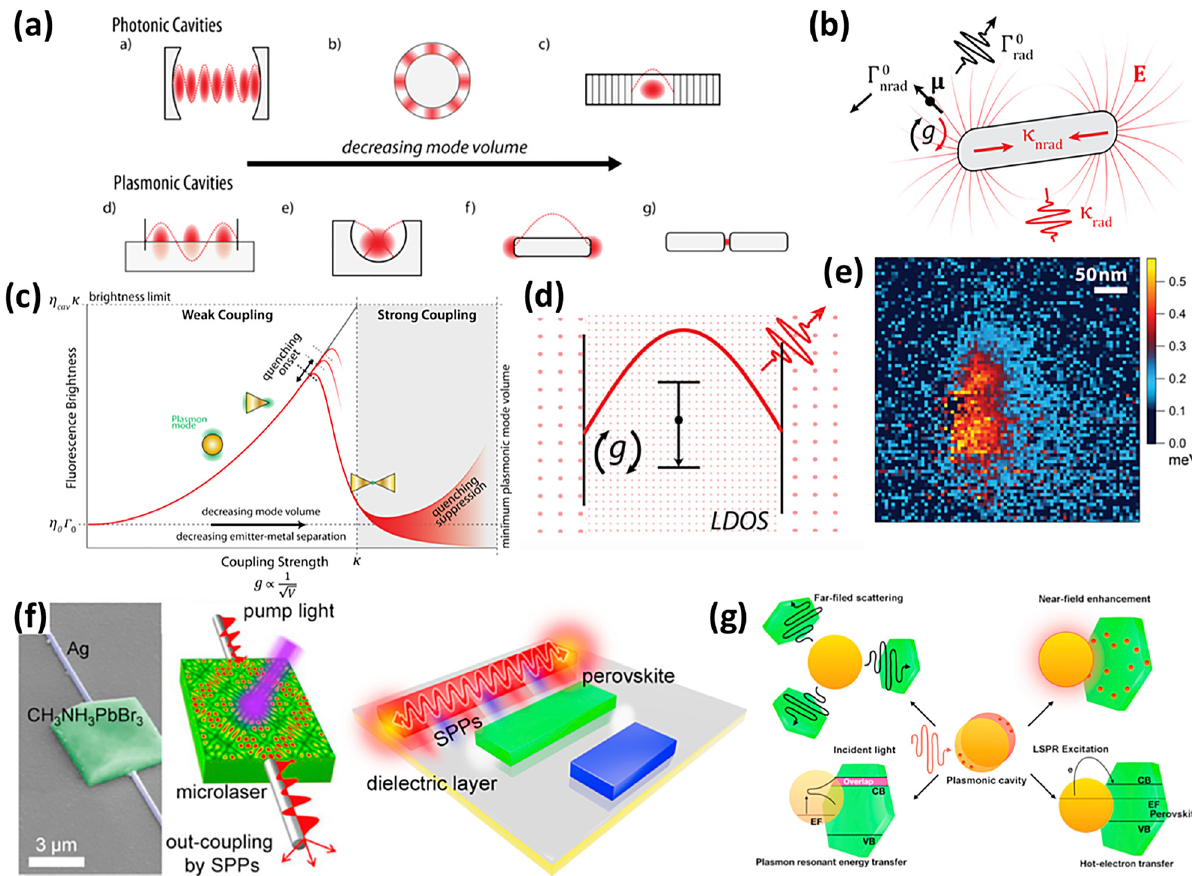
Figure 7: (a) Different forms of photonic cavities (mirrors, microresonators, micro-Bragg stacks, photonic crystals) and plasmonic cavities (trapped standing wave-type SPP cavities, collapsed structures with localized modes, dipole nanoantenna and coupled gap plasmon system respectively). (b) Schematic indicating the various energy dissipation pathways for an excited emitter with dipole moment ( μ ) in a plasmonic cavitymode (E). (c)Graphic illustrating the increaseof brightnessof a quantumemitterfrom the uncoupled free-spacevalueto the theoretical maximum when coupled to a plasmonic nanocavity, given a saturated pumping regime. Here, η 0 is the emitter quantum ef fi ciency, η cav is the radiation ef fi ciency of the cavity, Γ 0 the spontaneous emission rate of the uncoupled molecule, and κ the total cavity decay rate. (d) A cavity provides a frequency-speci fi c way to locally increase the density of states. By placing an emitter in a cavity resonant to its emission, the rate, with which it emits can be considerably enhanced. (e) Map showing coupling strength as a nanoantenna is scanned over an excited single fl uorescent molecule at a particular height separation extracted using lifetime values recorded at each point using time-correlated single